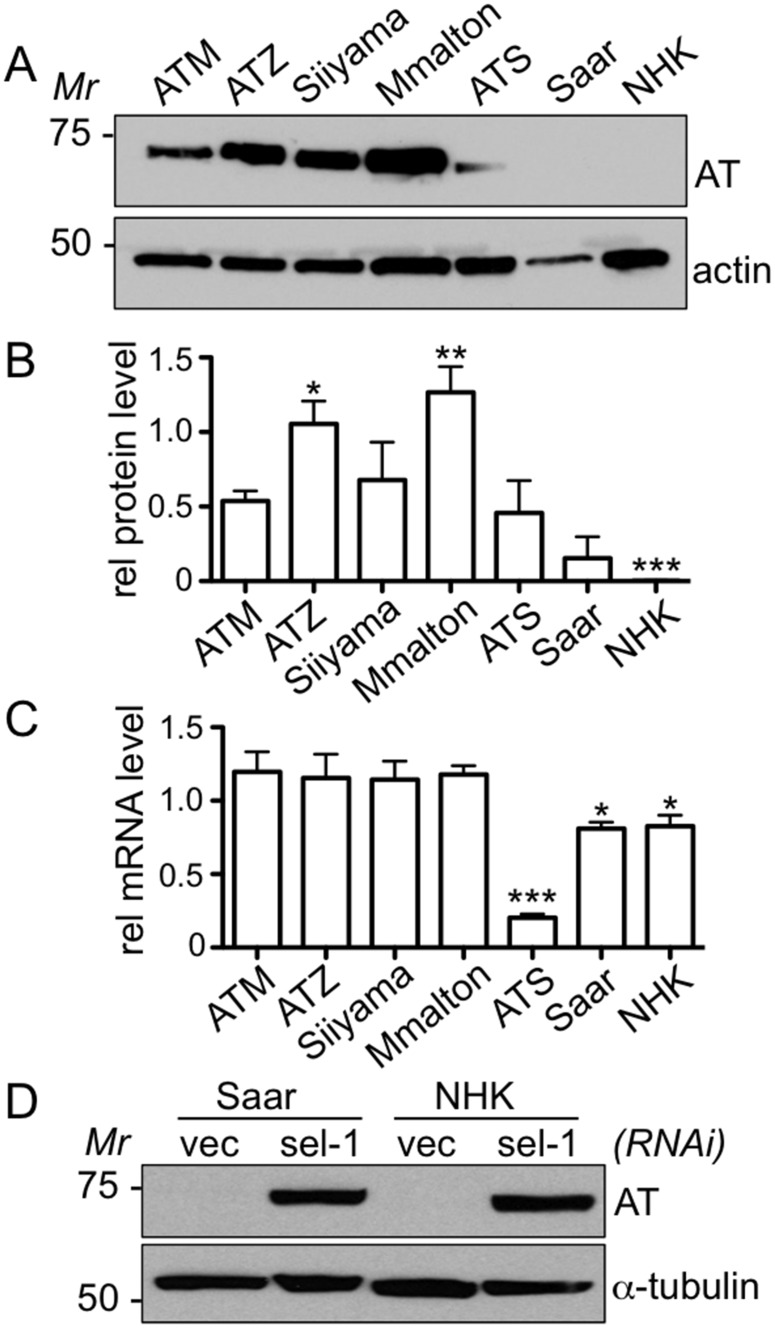
Immunoblots of AT variant transgenic lines.Western blot analysis of lysates from animals expressing different AT variant transgenes. The steady-state levels of WT and mutant sGFP::AT fusion proteins under denaturing conditions (A, upper panel). Actin serves as a loading control (A, lower panel). Relative AT protein levels as determined by densitometry (B). Statistical significance was determined using two-tailed student's t-test, comparing each AT variant line to ATM. Relative mRNA levels as determined by qPCR (C). Statistical significance was determined using two-tailed student's t-test, comparing each AT variant line to ATM. Lysates from null mutants sGFP::Saar and sGFP::NHK, exposed to vector(RNAi) or sel-1(RNAi) probed with GFP (D, upper panel) or α-tubulin (D, lower panel).